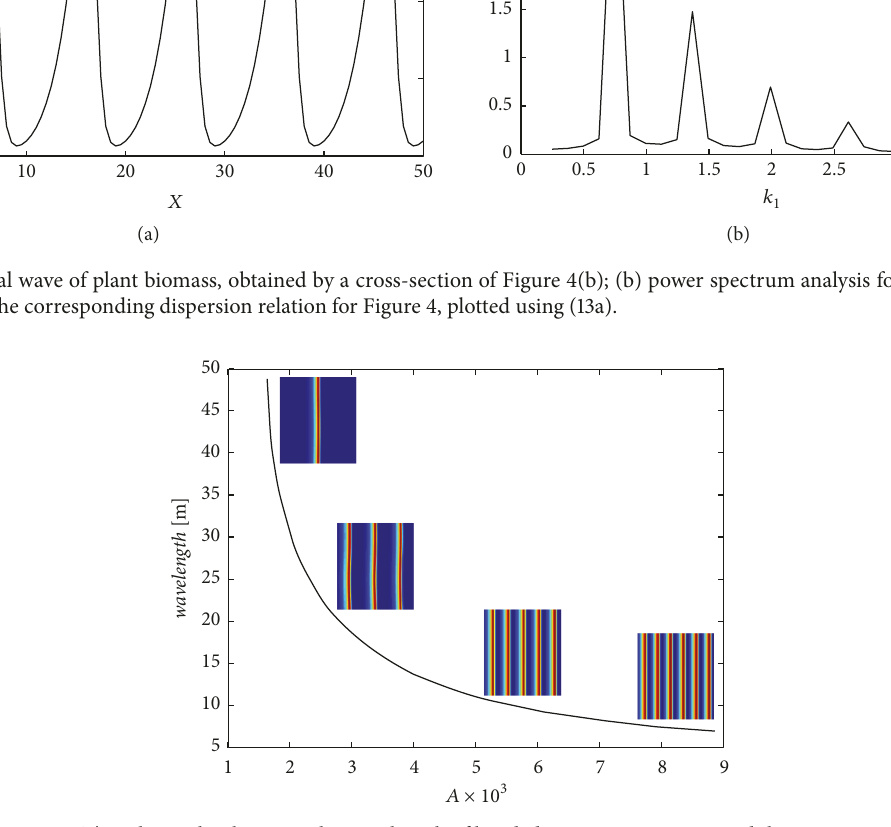
Figure 6: The relationship between the wavelength of banded vegetation patterns and the parameter 𝐴